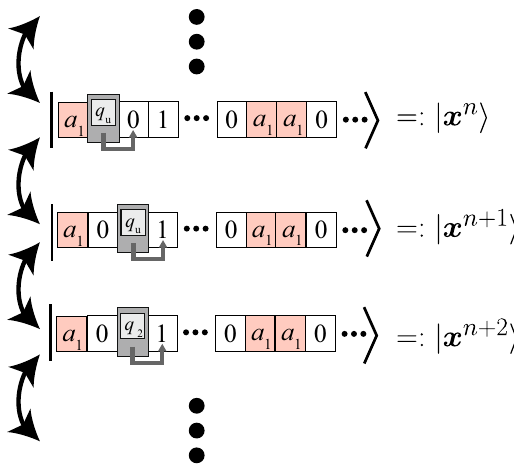
Fig. 3 Evolution of the quantum state of the total system. We draw a possible hopping between quantum states in the computational basis. Although here, we depict only the fi rst and second layers for visibility, the quantum state actually consists of three layers. Similar to the Feynman- Kitaev Hamiltonian case, the total Hamiltonian induces the forward and backward one-step time evolution of the TM. We denote the state of the classical TM at the n th step by x n . The symbols a 1 , 0 and 1 represent the states of cells, and q u and q 2 represent the internal states of the